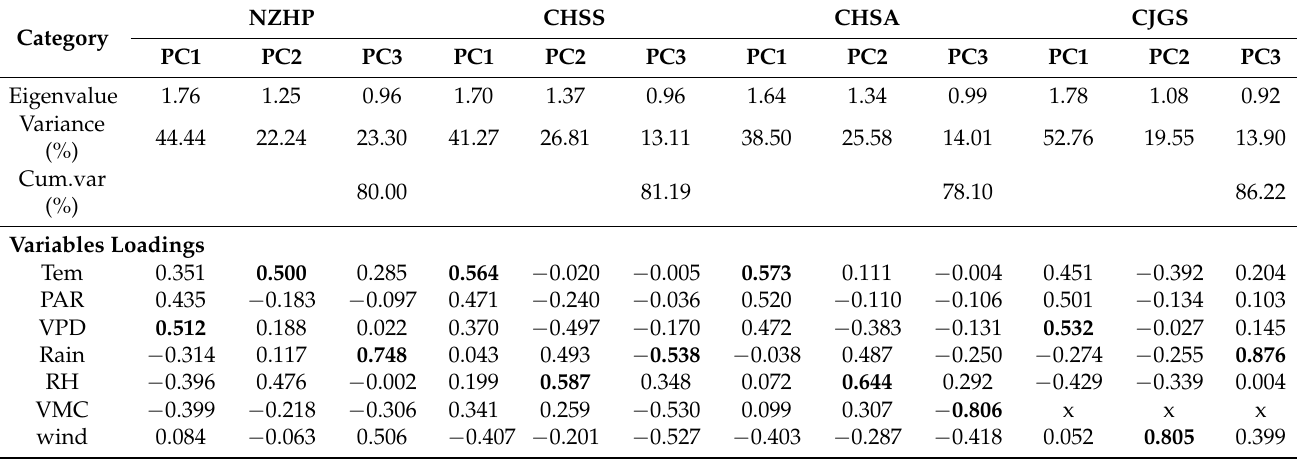
Figure 6. Relationship between DBH and daily whole tree water use with standard error for sample trees in each site during two-year period. We transformed DBH values for each stand to allow comparison across the sites. Table 4. The first three principal components describing the daily sap flow of four research forest stands over two years of study period. Eigenvalues, variance explained (%) and correlations between each variable and principle component are loaded. The strongest term for each component is shown in